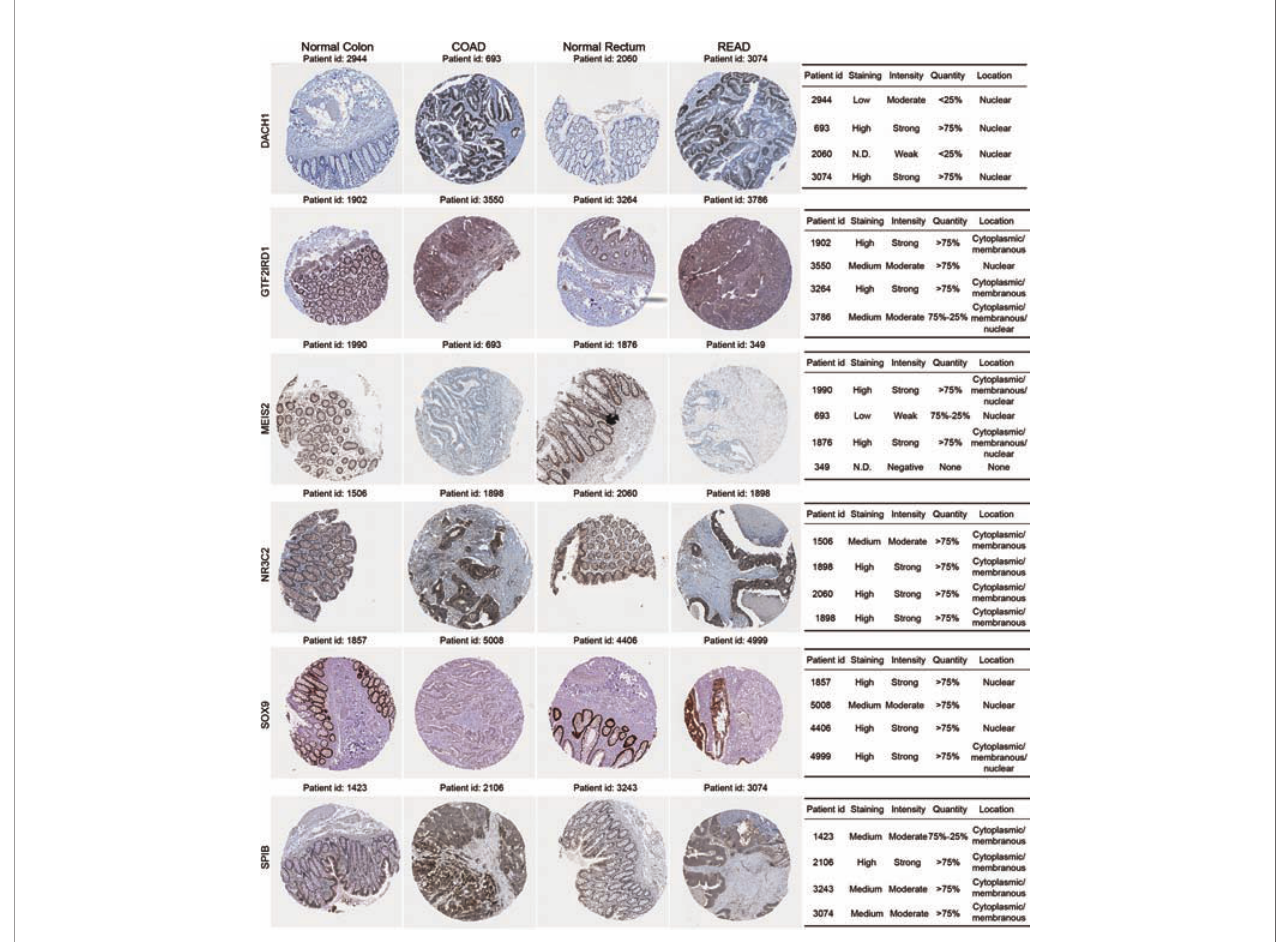
FIGURE 5 | Immunohistochemistry validation for dynamic DE-TF signature in the Human Protein Atlas database. Immunohistochemical images were obtained from the Human Protein Atlas database for six